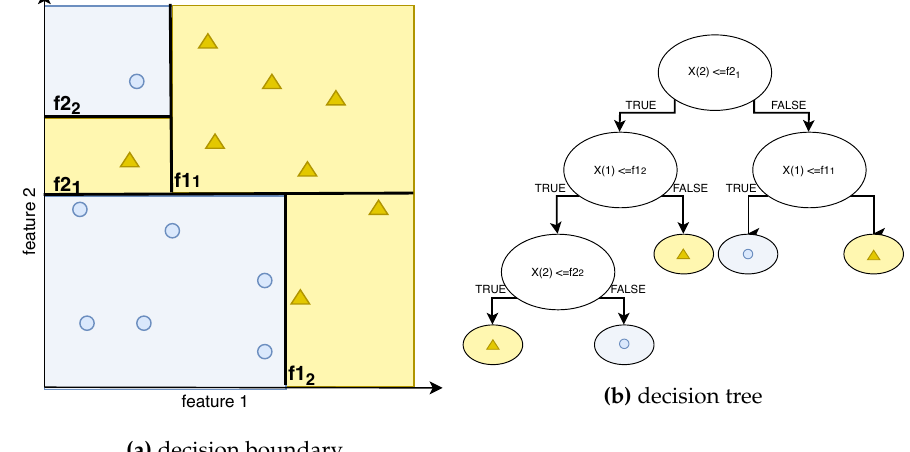
Figure 2. Decision tree—tree with depth